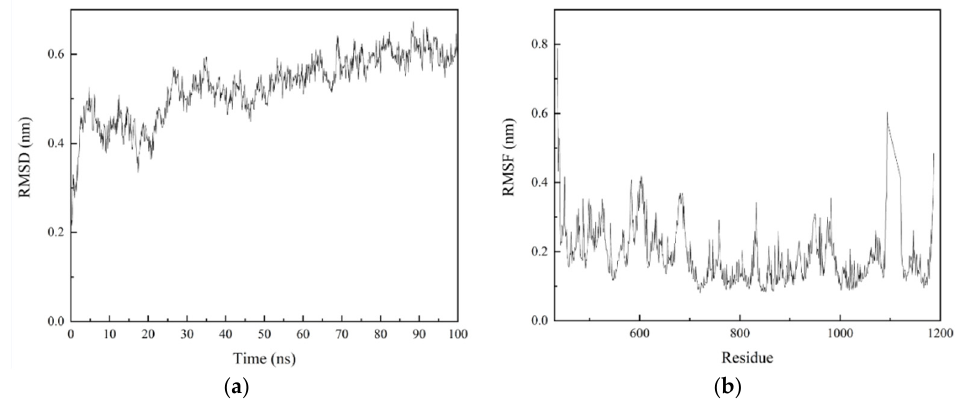
Figure 5. Molecular dynamics of topoisomerase-II with PSAH 5c . ( a ) RMSD diagram of topoisomerase-II and ( b ) RMSF diagram of topoisomerase-II with 5c .